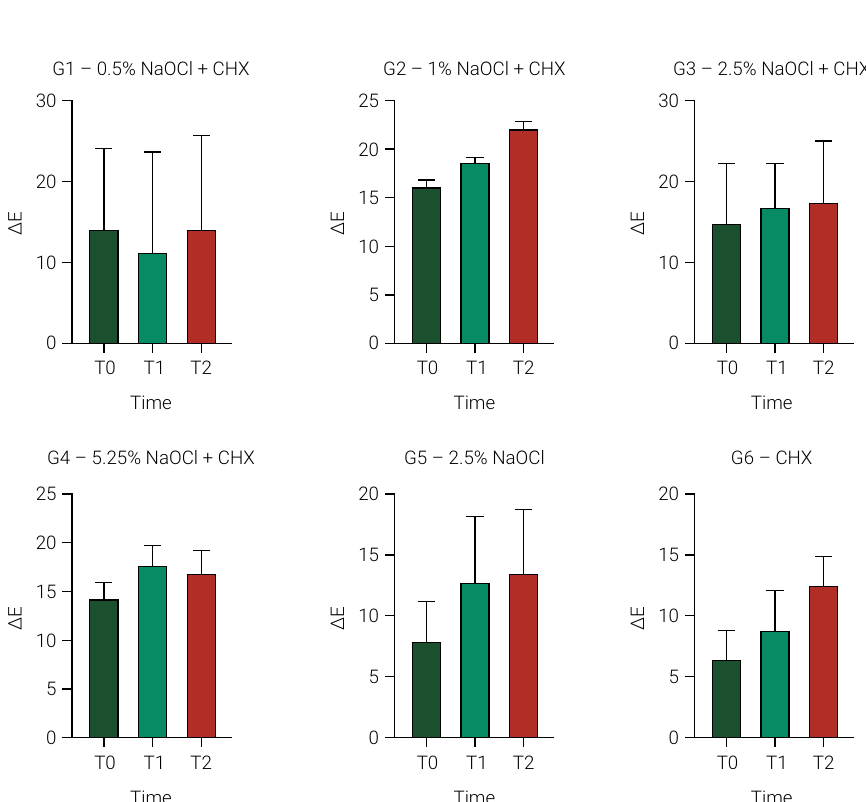
Figure 2. Mean and standard deviation of variation of the color (DE) of the experimental and control groups measured at the moment after biomechanical preparation (T0), immediately after the final irrigation (T1) and 24 hours after